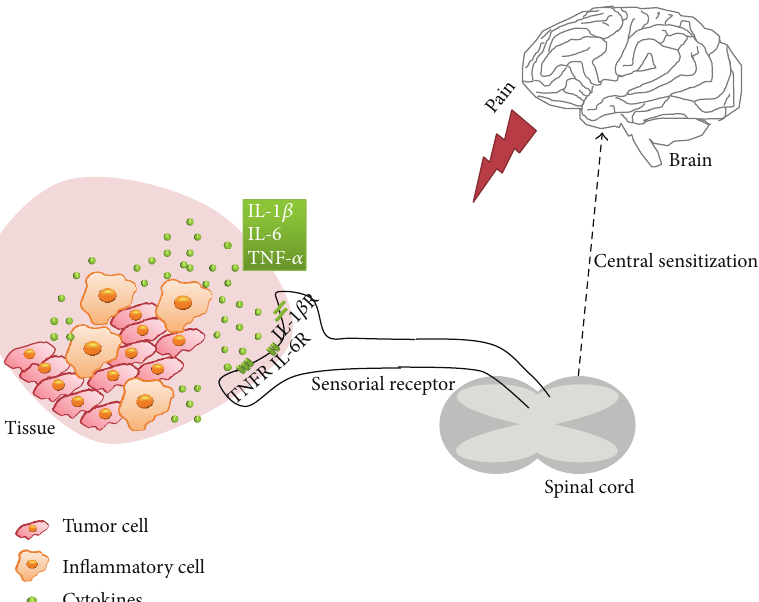
Figure 2: Cytokines in cancer pain. The tumor is composed not only by cancer cells but also by inflammatory cells, among others. The inflammatory cells present in tumor tissue release cytokines that sensitize the sensorial receptor. The painful stimuli, mediated by cytokines, are detected by the sensorial receptor and are transmitted to neurons in spinal cord. The signal is then transmitted to the brain. Adapted from Molecular Mechanisms of Cancer Pain, Nature Reviews